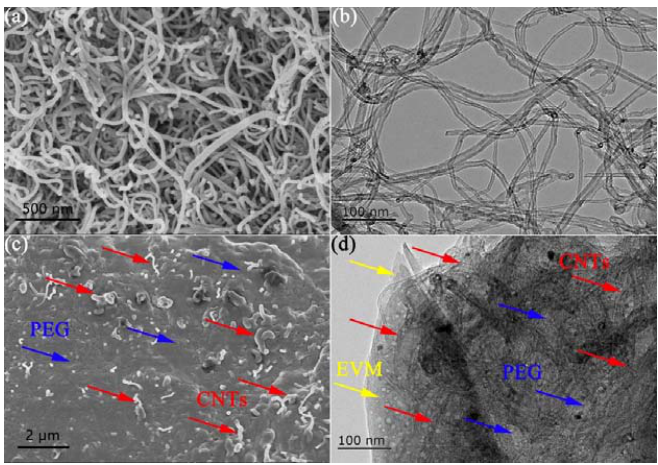
Figure 4. ( a ) SEM ( × 50.0 k) and ( b ) TEM images of CNTs; and ( c ) SEM ( × 10.0 k) and ( d ) TEM images of PCE5.20.